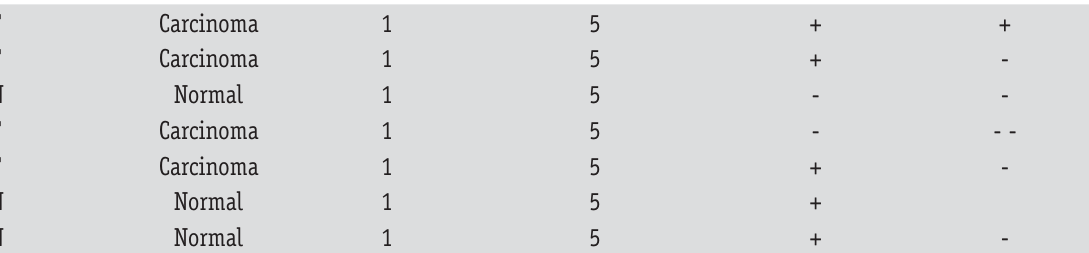
FT: amostra de fígado tumoral; FN: amostra de fígado normal adjacente ao tumor; RT: amostra de rim tumoral; RN: amostra de rim normal adjacente ao tumor; MCLs: número de microdissecções realizadas para cada amostra.